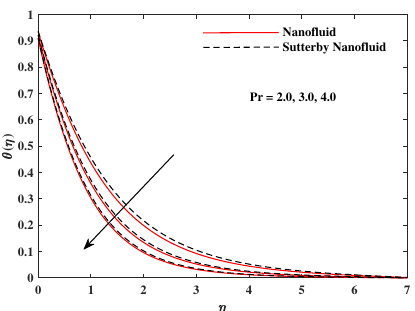
Figure 8. θ ( η ) fluctuate with Pr and A .